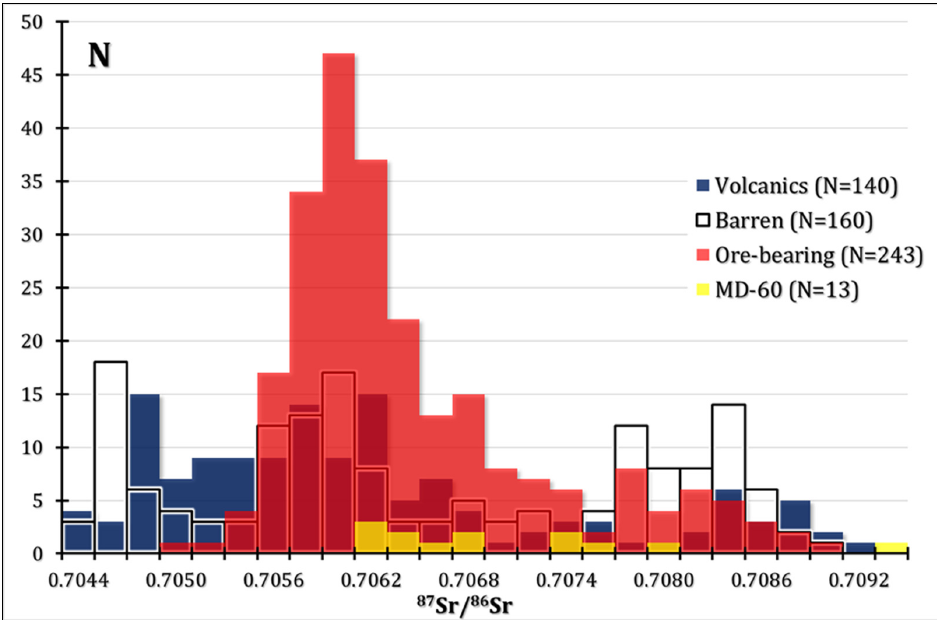
Figure 10. Histograms of the initial 87 Sr/ 86 Sr in magmatic rocks of the Norilsk region. Data sources are shown at the Figure